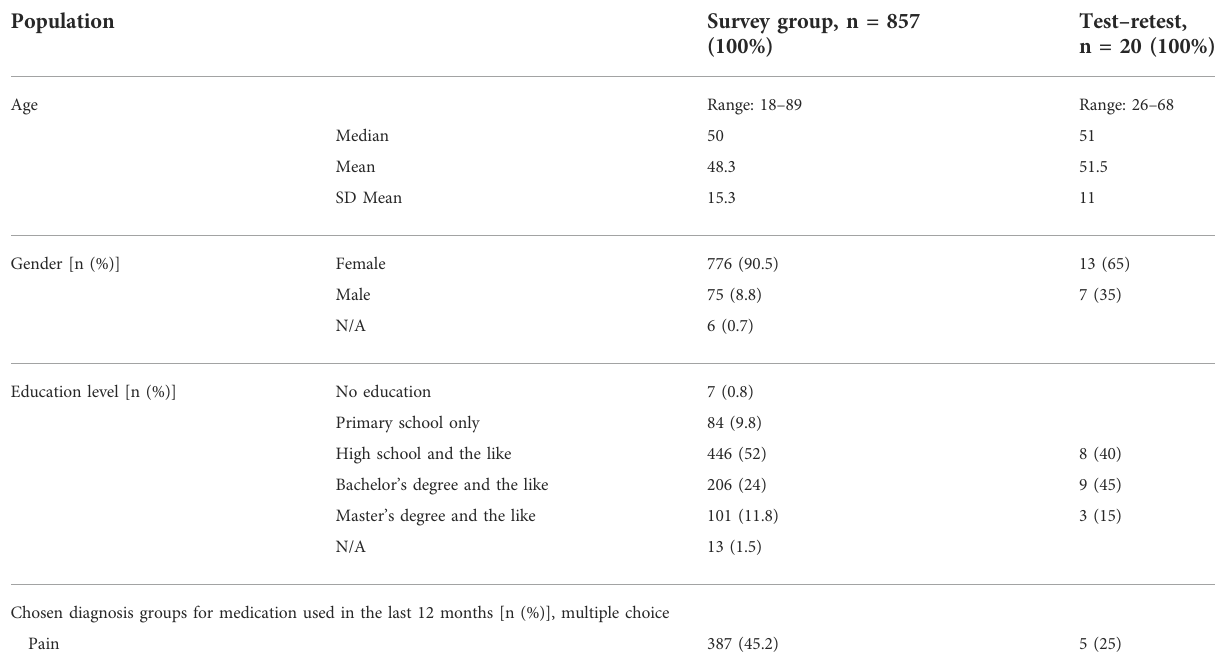
TABLE 2 Demographics of the survey group and test – retest